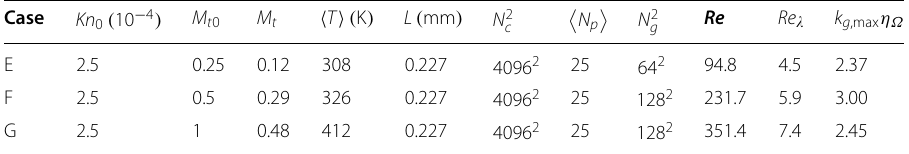
300 K, P 0 1 bar and ρ 0 = =